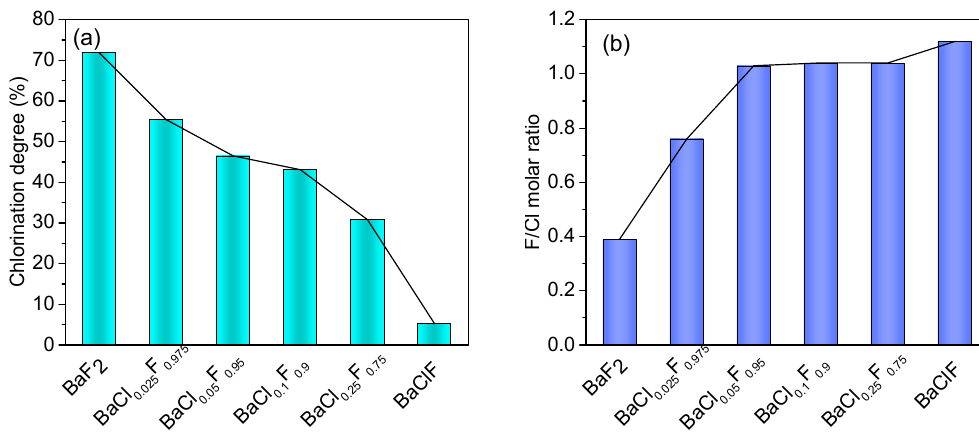
Figure 4. Chlorination of catalysts during the pyrolysis of HCFC-142b at 350 ◦ C. ( a ) Chlorination degree of catalysts after time on stream of 24 h. The chlorination degree is calculated according to the molar ratio of F amount replaced by Cl in the reaction to the amount of F in the fresh catalysts. ( b ) F / Cl molar ratio in the spent catalysts. The elemental amounts of all the catalysts were determined by EDS technique.